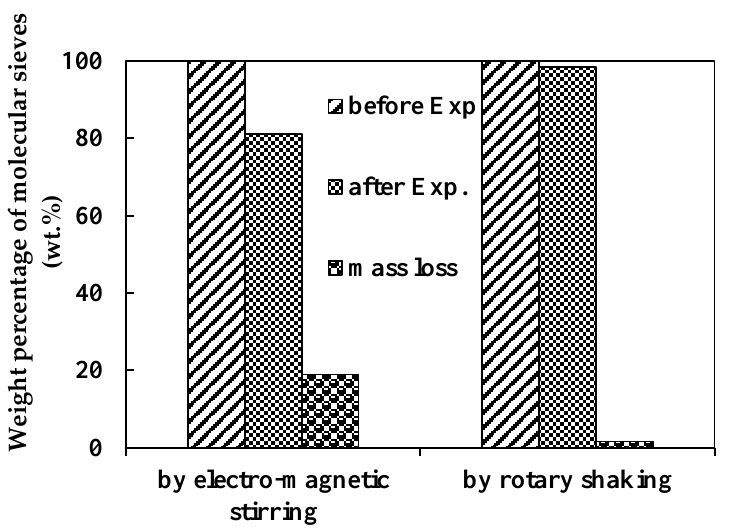
Figure 6. Comparison of weight percentages of molecular sieves before and after water-removal experiments vibrated by electromagnetic stirring and rotary shaking.